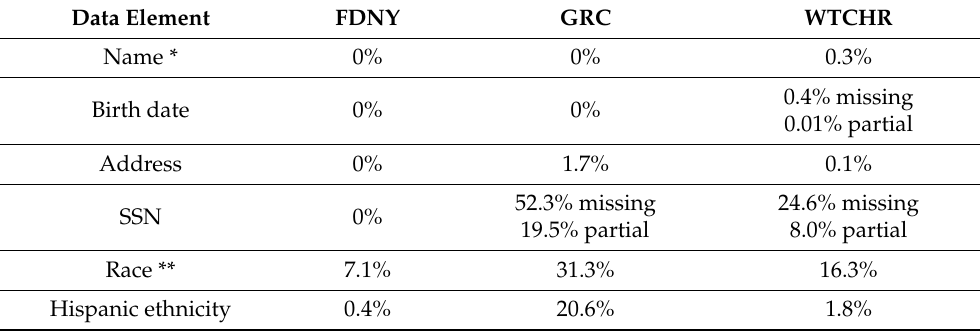
Table 2. Summary of partial and missing information for data files provided to NYSCR for pooling. Data